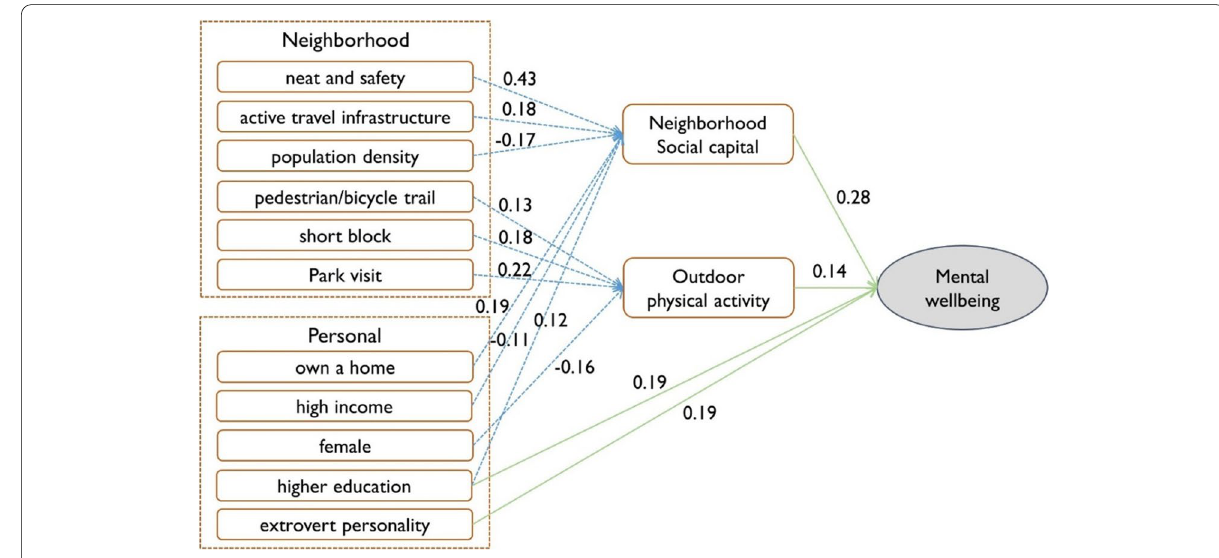
Fig. 4 Path analysis